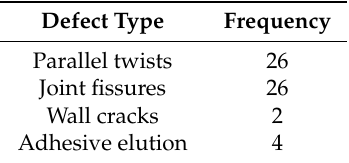
Table 8. Defects due to abiotic causes